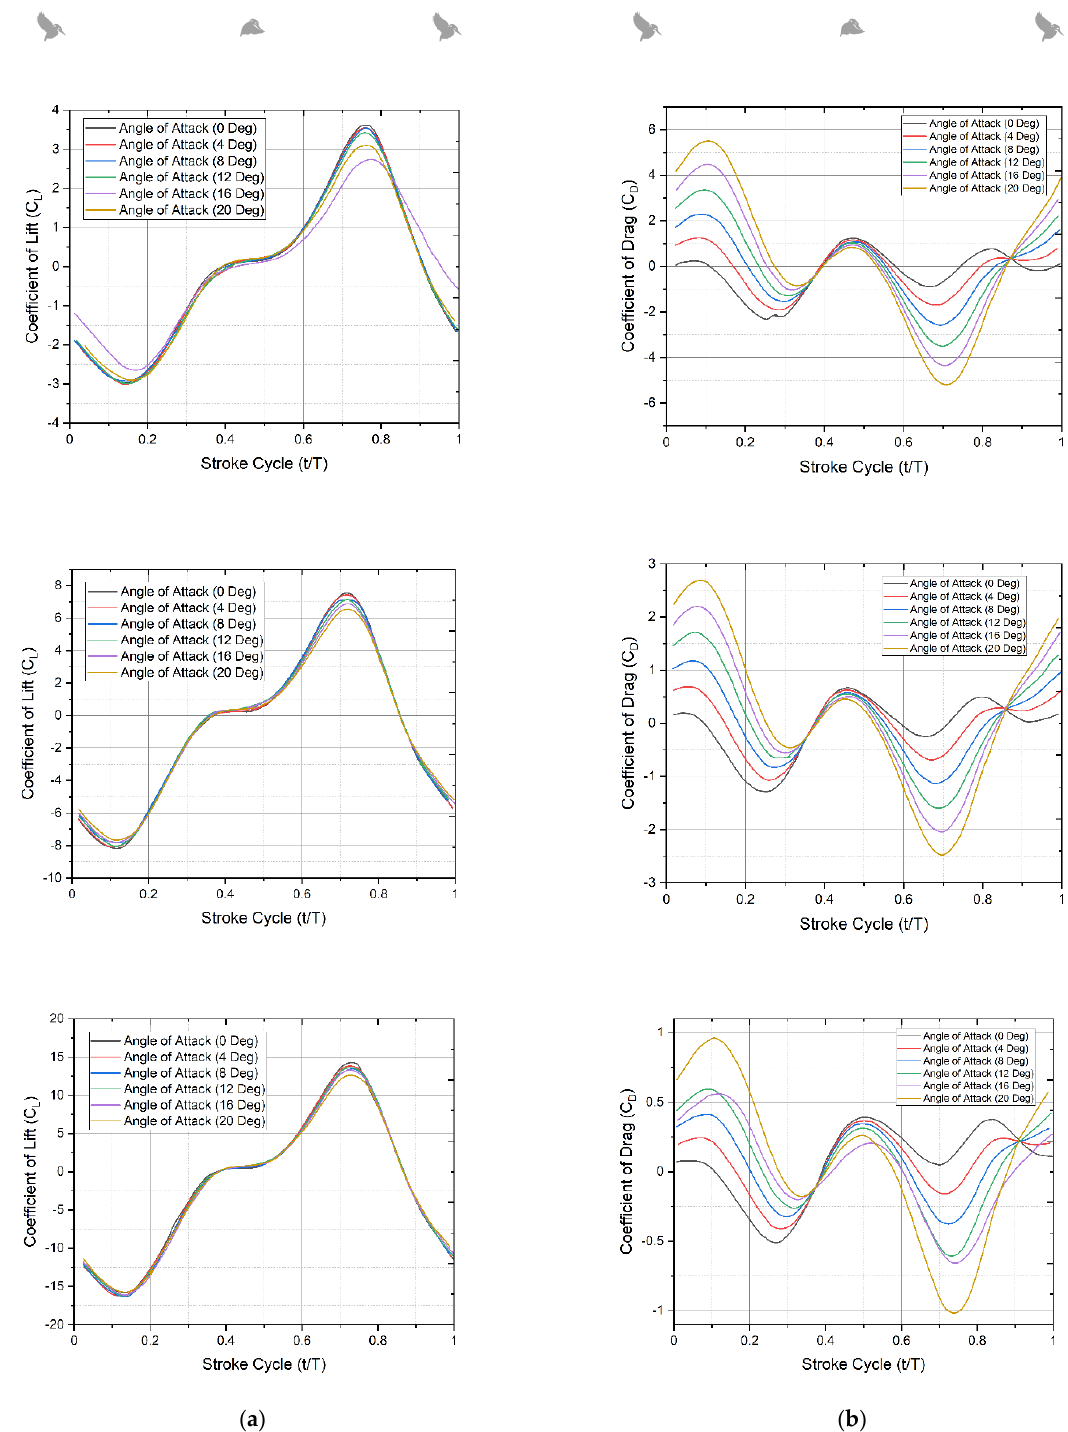
Figure 11. ( a ) Development of lift force during each stroke ( 𝐶 𝐿 v/s t/T) at 4.4 m/s at f = 11 Hz; Lift force during each stroke ( 𝐶 𝐿 v/s t/T) at 4.4 m/s at f = 16 Hz and lift force during each stroke ( 𝐶 𝐿 v/s t/T) at 4.4 m/s at f = 21 Hz; ( b ) drag force during each stroke ( 𝐶 𝐷 v/s t/T) at 4.4 m/s at f = 11 Hz; drag force during each stroke ( 𝐶 𝐷 v/s t/T) at 4.4 m/s at f = 16 Hz and drag force during each stroke ( 𝐶 𝐷 v/s t/T) at 4.4 m/s at f = 21 Hz. Forces are measured at different AoA ranging from 0° to 20°.